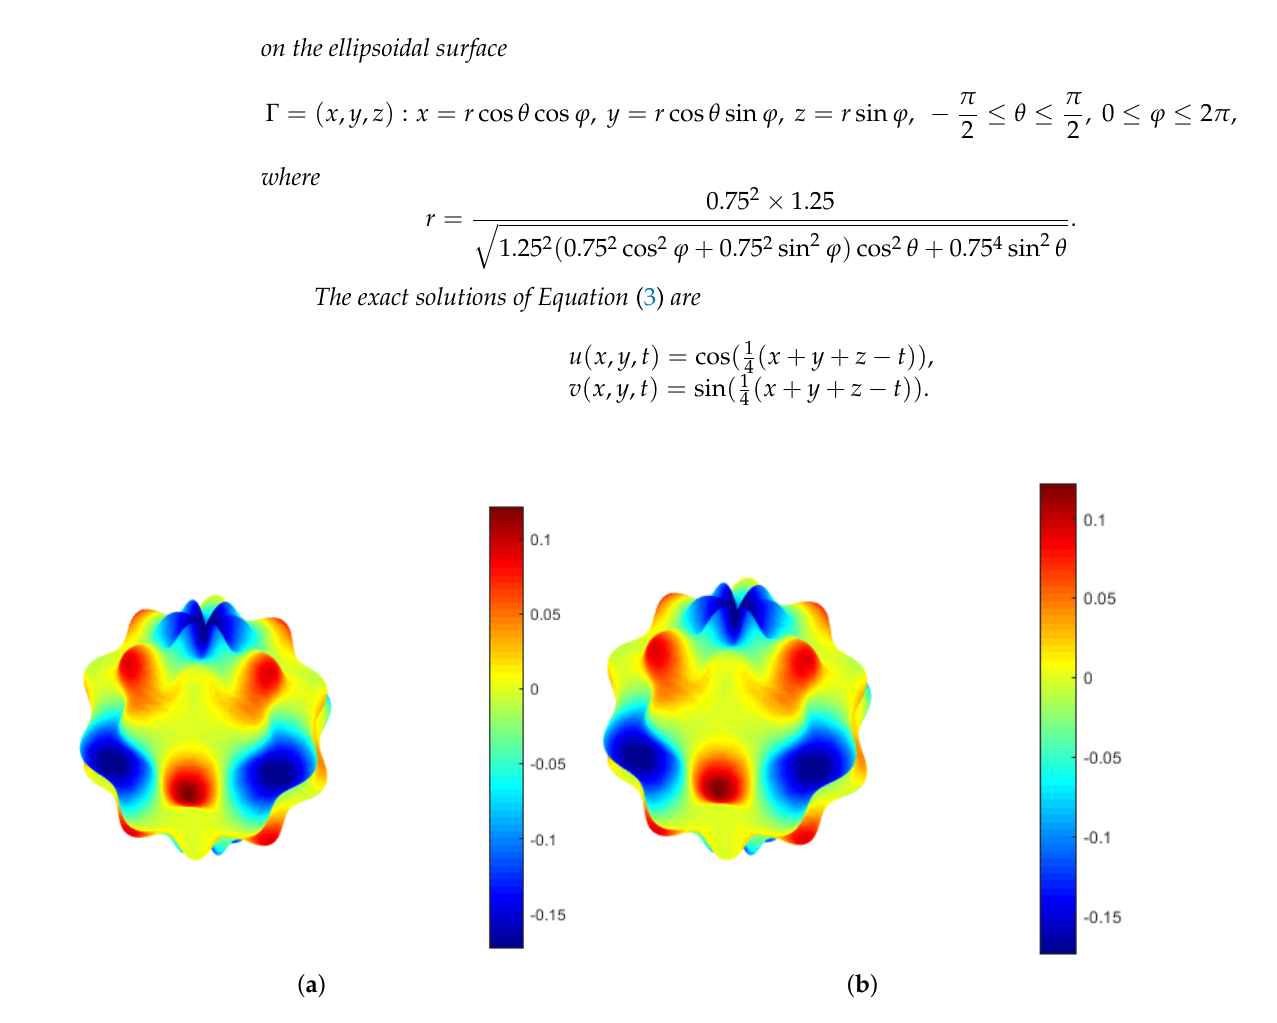
and τ = 0.5 dx 2 8